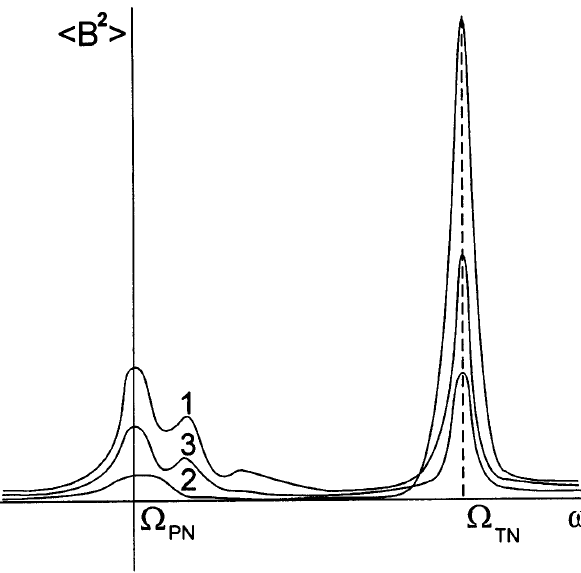
Fig. 4. Schematic diagrams of spectral density for components of a disturbed magnetic field in the case of a small attenuation (cid:133) (cid:109) N (cid:28) 1